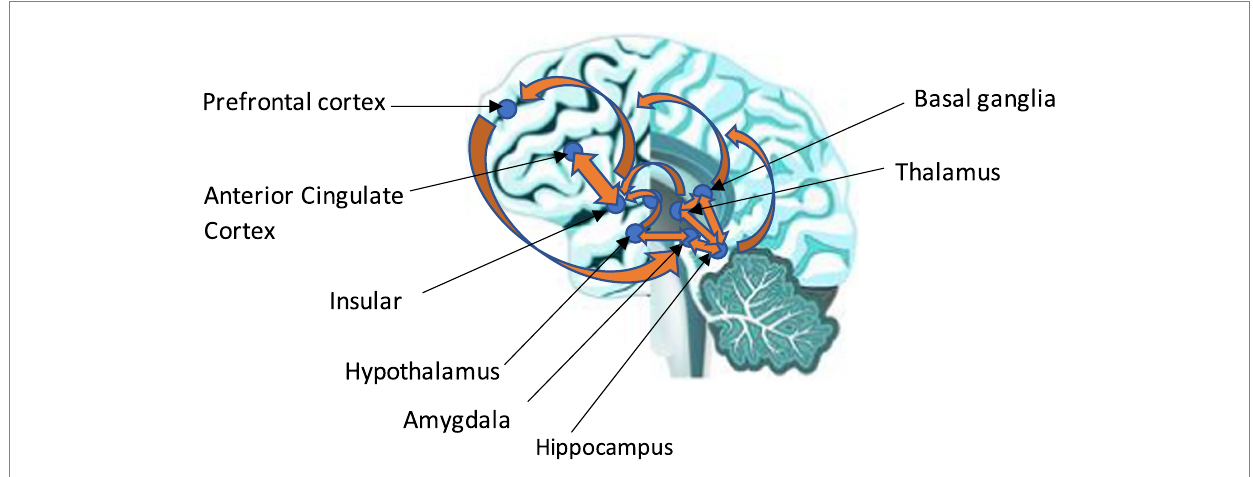
FIGURE 10 A combined lateral and medial view of the limbic, insular cortex, and prefrontal cortex axes. The biopsychological level, neuro-integrated, and embodied